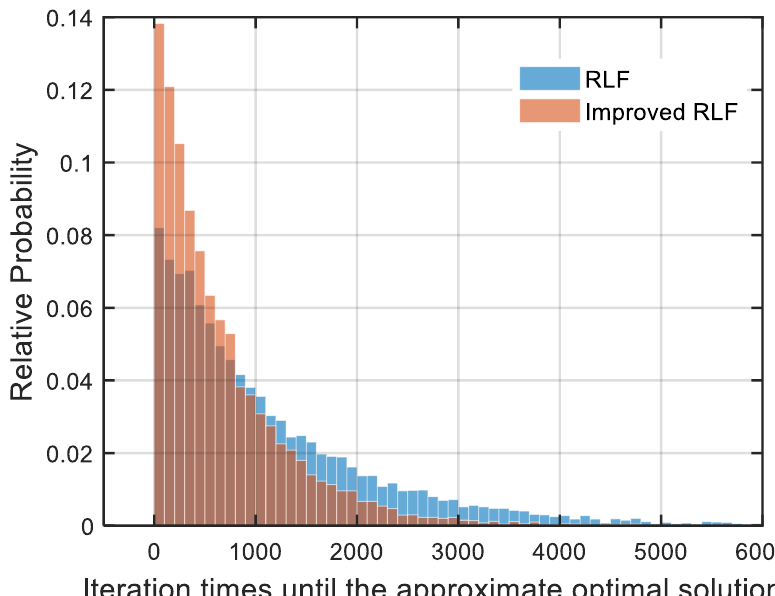
Figure 6. Comparison of the calculation speed between the RLF algorithm and the improved-RLF algorithm. The satellite configuration was the walker 120/12/6 at an altitude of 1000 km. Both RLF and improved-RLF were run 10,000 times, and the number of iterations was 6000. With a probability of 0.0119, the solution of RLF algorithm was found to be greater than the approximate optimal solution, while in all experiments, the optimal solution was obtained in 6000 iterations with the improved-RLF algorithm.